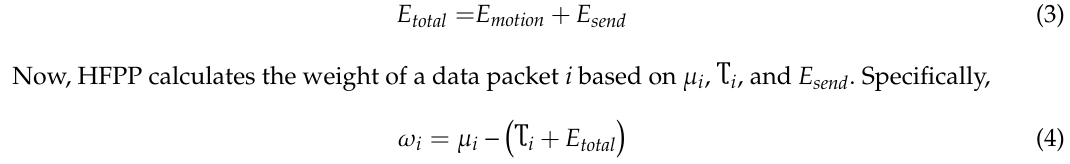
Table 1. Summary of notations.